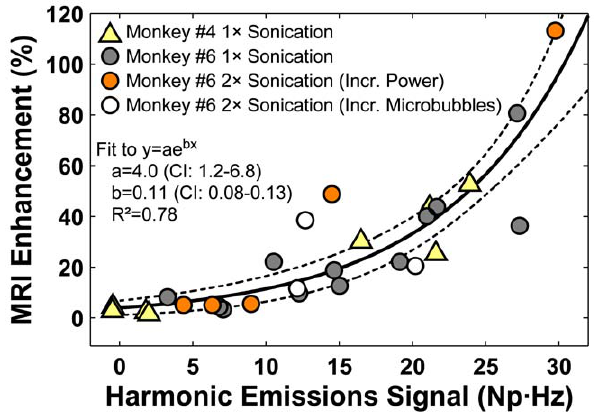
Figure 7. MRI signal enhancement after Gd-DTPA injection plotted as a function of the harmonic emissions signal strength. Data are shown for individual subsonication targets delivered in the cingulate cortex in monkeys # 4 and # 6. The MRI enhancement was found in a 3 6 3 voxel ROI centered on the subsonication target. The MRI signal increased nonlinearly as a function of the strength of the harmonic emission. A good correlation (R 2 : 0.78) was found in a fit of the data to an exponential (solid line; dotted lines: 95% confidence intervals). Data shown are for the subsonication target that exhibited the greatest MRI signal enhancement for each of 28 multi-target sonications that were performed in the cingulate cortex in this study and included results from experiments where a second sonication was applied at either a higher power level or with an increased microbubble